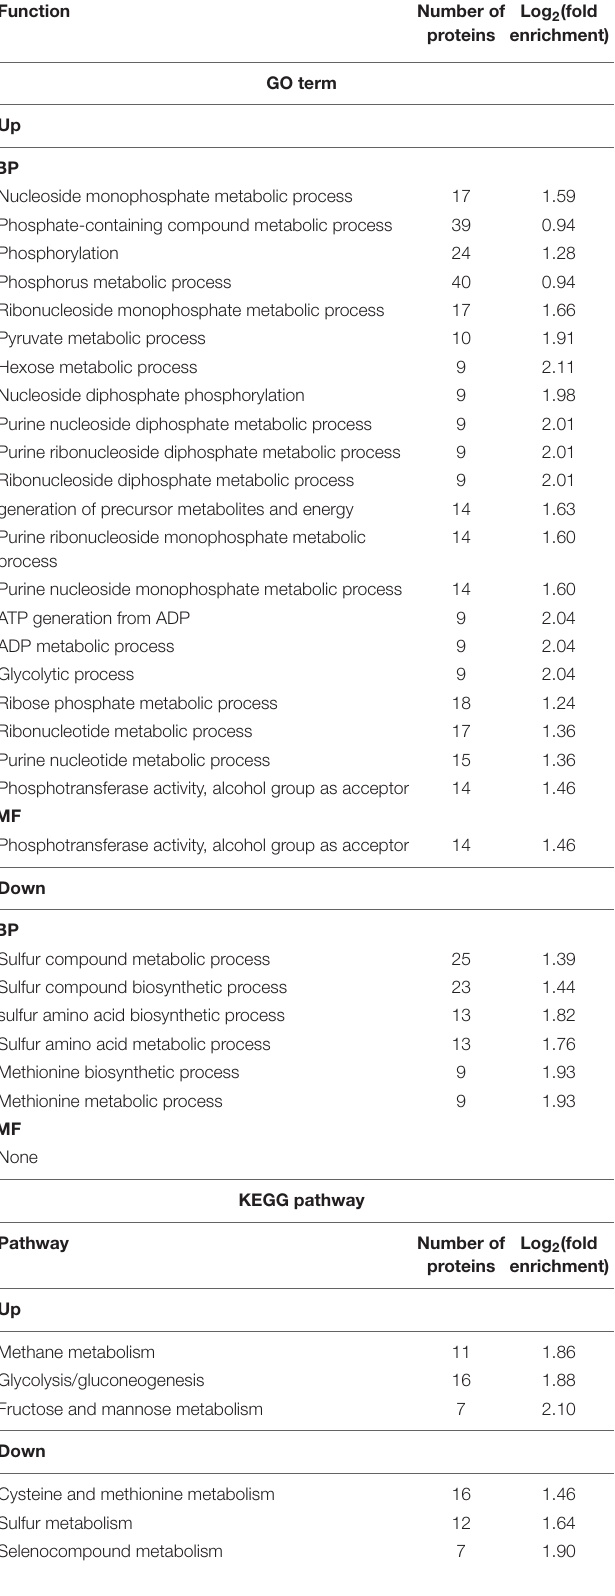
TABLE 1 | The enrichment analysis of the Gene Ontology (GO) and Kyoto Encyclopedia of Genes and Genomes (KEGG) pathway.